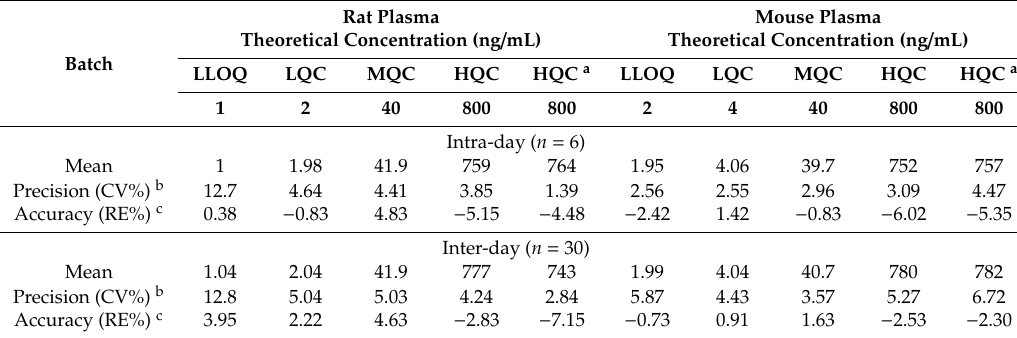
Table 3. Accuracy and precision of SH-1242 determinations in rat and mouse quality control (QC)